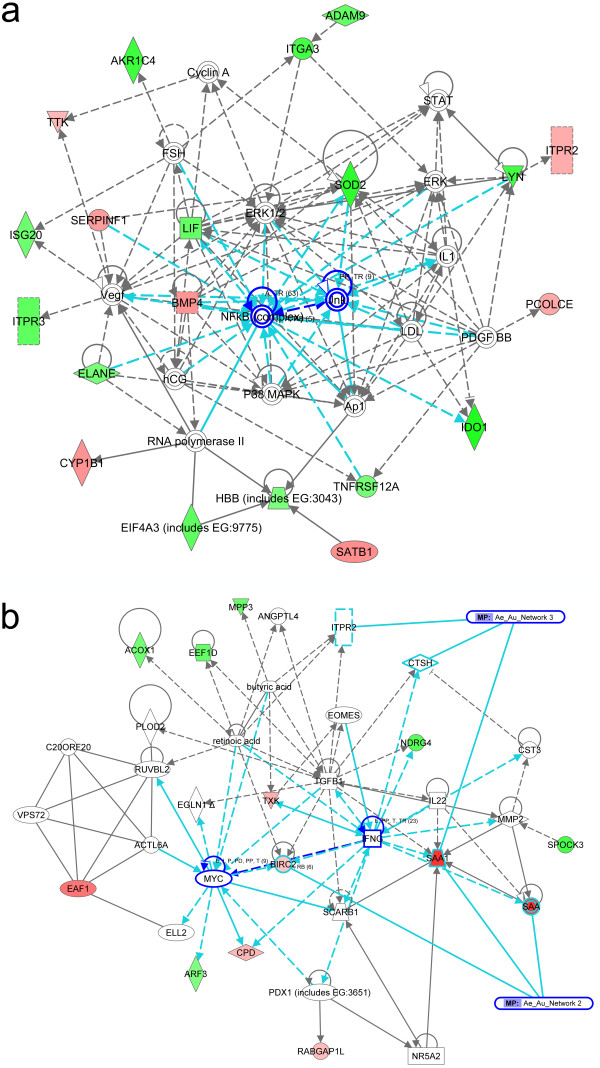
IPA-based pathway analysis of differential expressed genes. (a) Red and green designations indicate over- and underexpressed genes in the respective groups. Blue arrows and circulations indicate central nodes of the networks. (b) Red and green designations indicate over- and underexpressed genes in the respective groups. Blue arrows and circulations indicate central nodes of the networks.